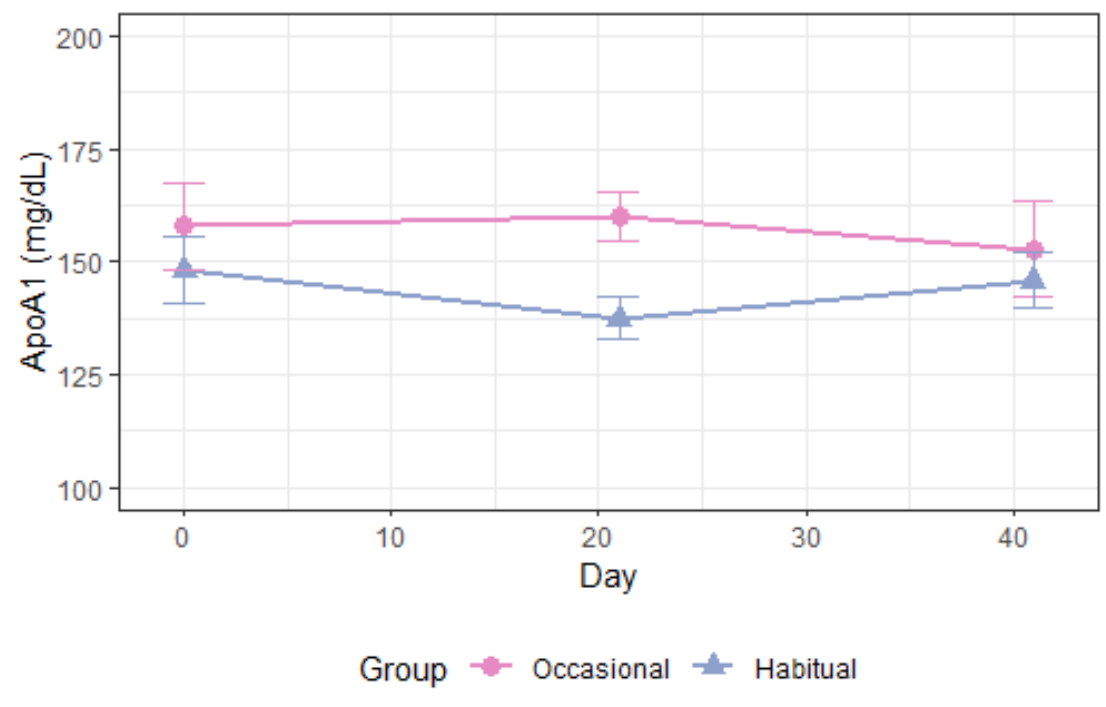
Figure 3. Total apoA1 during 3 weeks in period 1 and 3 weeks in period 2. Occasional drinkers ( n =